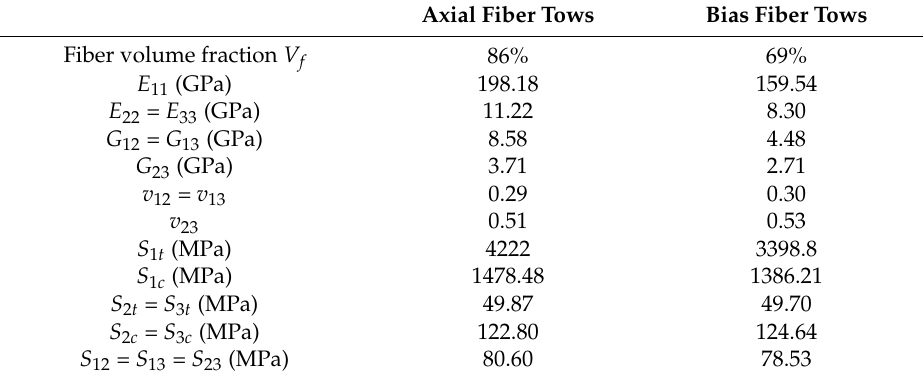
Figure 2. ( a ) Composition of a unit cell finite element model. ( b ) Finite element mesh of axial tension notched model. Table 4. Mechanical properties of axial and bias fiber tows.